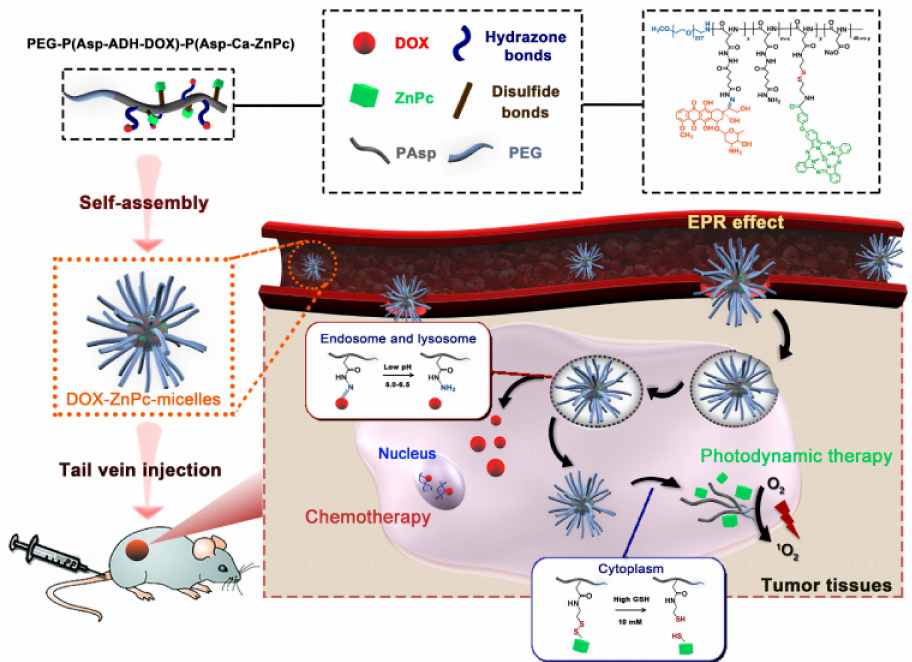
Scheme 13. Schematic diagram showing the structure of the pH- and redox-responsive prodrug DOX- ZnPc-micelles and their mechanistic action for chemotherapy and PDT. Reprinted with permission from ref [85]. Copyright 2018